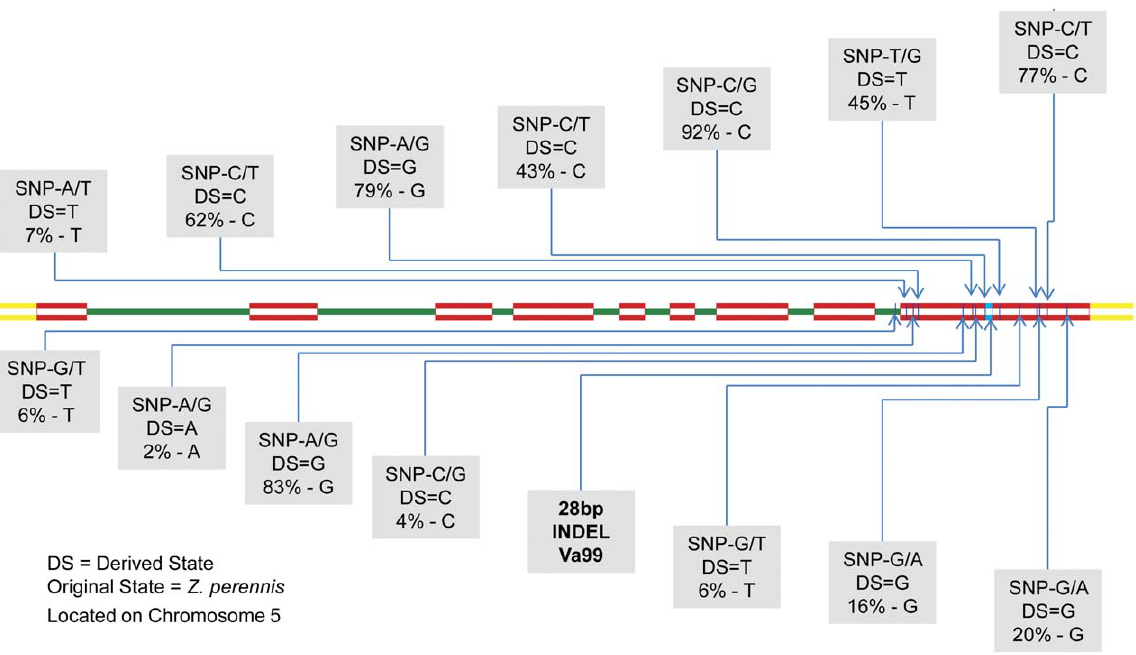
Figure 2. Sequence architecture of ZmLOX5 . ZmLOX5 consists of 9 exons (shown in red), and 8 introns (shown in green). ZmLOX5 has a shorter second intron, spanning 511 bp. ZmLOX5 is located on the reverse strand of chromosome 5:12,274,159–12,279,067, spanning 4908 bp (B73 RefGen_V2). Vertical blue lines in the final 3 9 exon of the gene are the relative locations of SNPs discovered from Sanger sequencing. An InDel of 28 bp was found in the inbred line Va99 and located in the final exon of ZmLOX5 , shown here in light blue. Their base pair change, derived state (as compared to Z. perennis ), and derived state percentages are shown in the grey boxes.